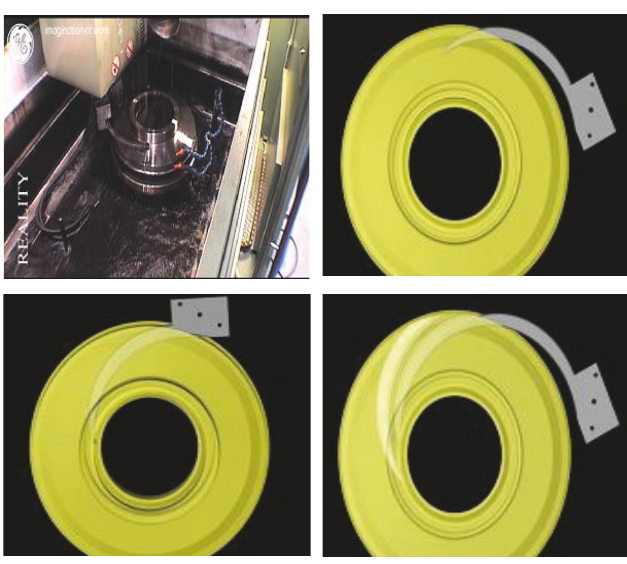
Figure 2: Impeller EDM